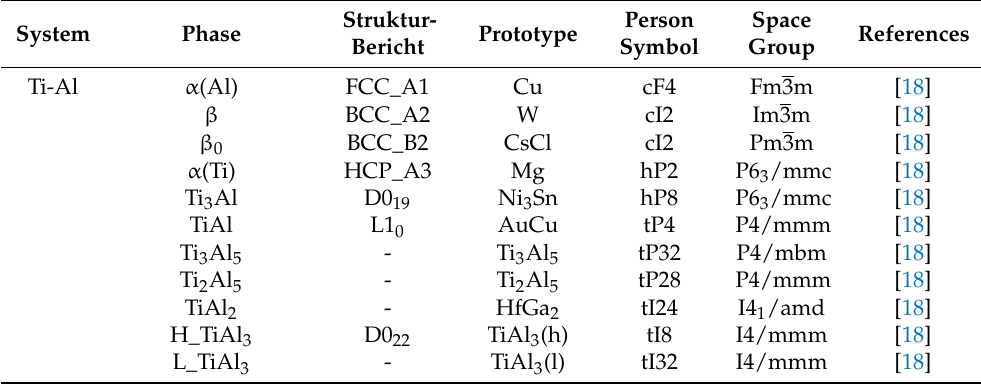
Figure 6. Calculated Fe-V phase diagram using the thermodynamic parameters obtained by Kumar et al. [35]. Table 1. Crystallographic data of individual phases in the six binary systems.